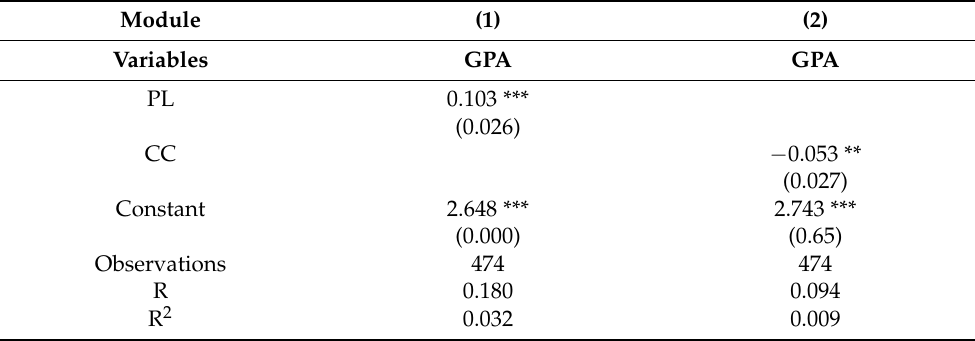
Table 10. Further analysis of course contents and practical lessons and their impact on GPA. Module (1) (2) Variables GPA GPA PL 0.103 *** (0.026) CC − 0.053 ** (0.027) Constant 2.648 *** 2.743 *** (0.000)